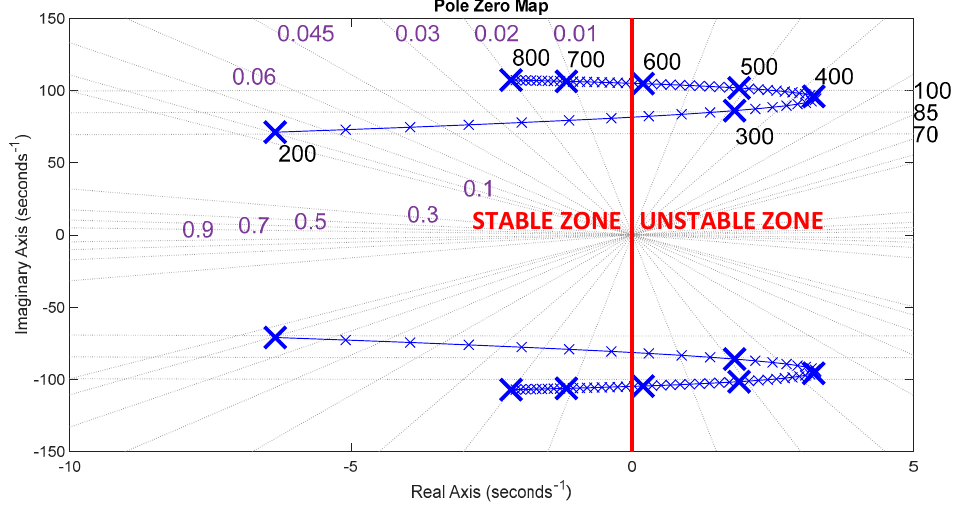
Figure 7. Small-signal model-based root locus with respect to the generator speed (blue crosses) with a bandwidth of 1 Hz for the generator speed control. Dashed lines illustrate iso-values of system damping (linear dashed lines), and iso-values of system angular frequency (horizontal dashed lines), the red line indicate the limit between stable and unstable zone: the ordinates axe.